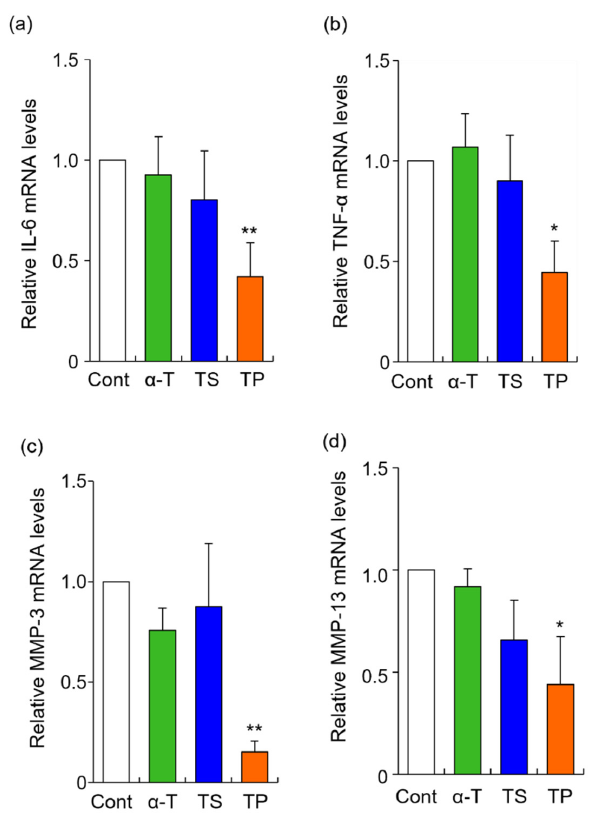
Figure 2. Effects of α -T, TS, and TP on the expression of IL-6, TNF- α , MMP-3 and MMP-13 mRNA in HFLS-RA. HFLS-RA cells were treated with 50 µ M α -T, 20 µ M TS, and 50 µ M TP for 24 h. IL-6 ( a ), TNF- α ( b ), MMP-3 ( c ), and MMP-13 ( d ) mRNA levels were determined by RT-PCR with these specific primer sets. Values represent the means of three individual experiments. Bars represent SD. * p < 0.05 and ** p < 0.01.